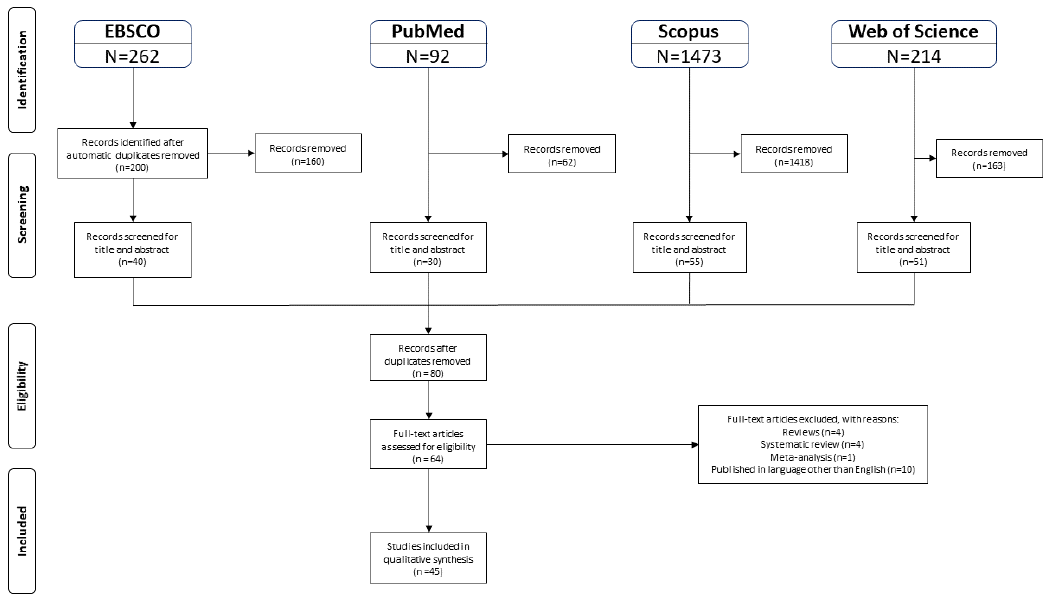
Figure 1. Flowchart of the selection procedure adapted from the Preferred Reporting Items for Systematic reviews and Meta-Analyses (PRISMA) [82].